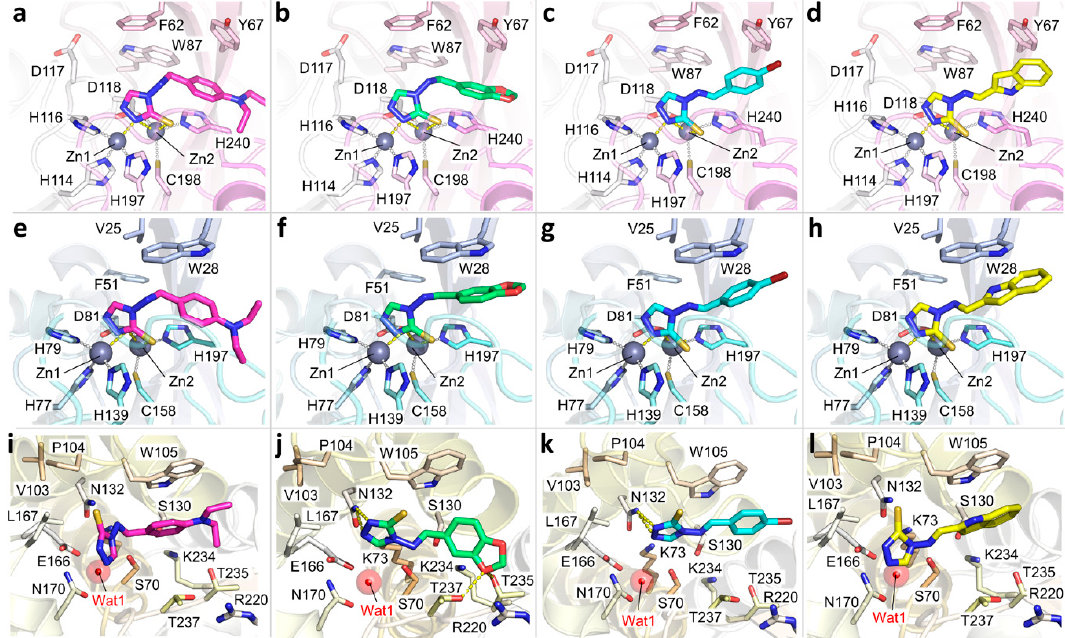
Figure 1. Docking pose of the compounds in VIM-1, IMP-1 and KPC-2. ( a – d ) Compounds 1d , 1f , 2b and 2g in VIM-1 binding site, respectively. ( e – h ) Compounds 1d , 1f , 2b and 2g in IMP-1 binding site, respectively. ( i – l ) Compounds 1d , 1f , 2b and 2g in KPC-2 binding site, respectively. The position originally occupied by the catalytic water wat1 in KPC-2 has been indicated. Even when the water was not retained in the docking simulations, none of the compounds occupied its position, nor was it able to generate valuable contact with it. Proteins are displayed as cartoon (VIM-1, magenta; IMP-1, light blue; KPC-2 dark yellow), zinc atoms are solid grey spheres and their coordination bonds are represented as grey dashed lines. The side chains of the relevant residues are shown as sticks and are labelled accordingly; ligands are depicted in thick, bright-coloured sticks. Hydrogen bonds formed by the ligand with the residues lining the pocket are shown as yellow dashed lines. The catalytic water in KPC-2 is labelled and shown as a red sphere. For clarity, residues have been numbered according to the PDB.